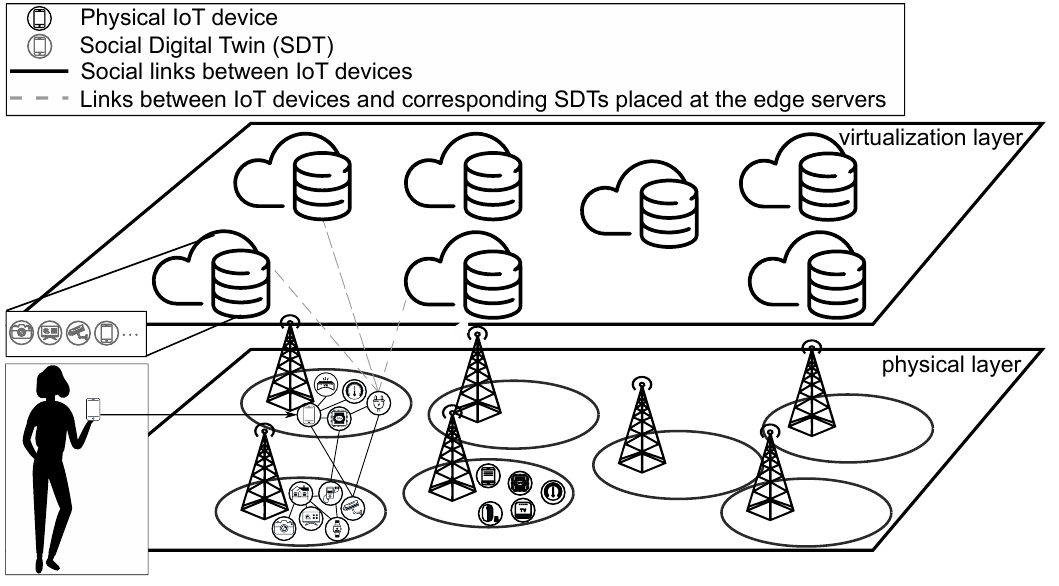
Figure 1. Layered Internet of Things (IoT)